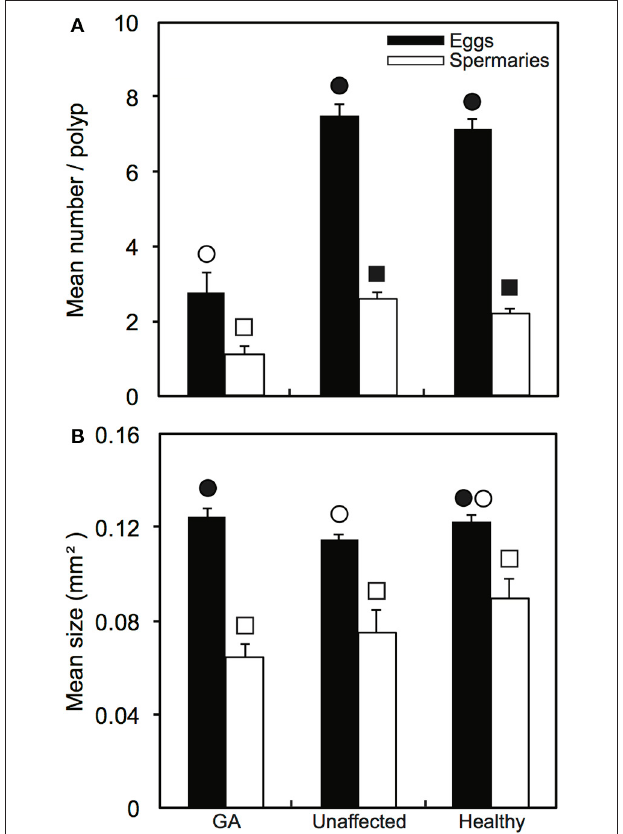
FIGURE 2 | Comparison of reproductive parameters (means ± SE) among healthy and diseased colonies, including paired growth anomaly (GA) and adjacent unaffected regions: (A) number of oocytes and spermaries produced per polyp ( n = 45 polyps per health state); and (B) sizes of oocytes ( n = 33, 53, 48 respectively) and spermaries ( n = 42, 75, 75, respectively). Symbols of the same shape indicate statistical comparisons. Significant comparisons are indicated by differences in symbol